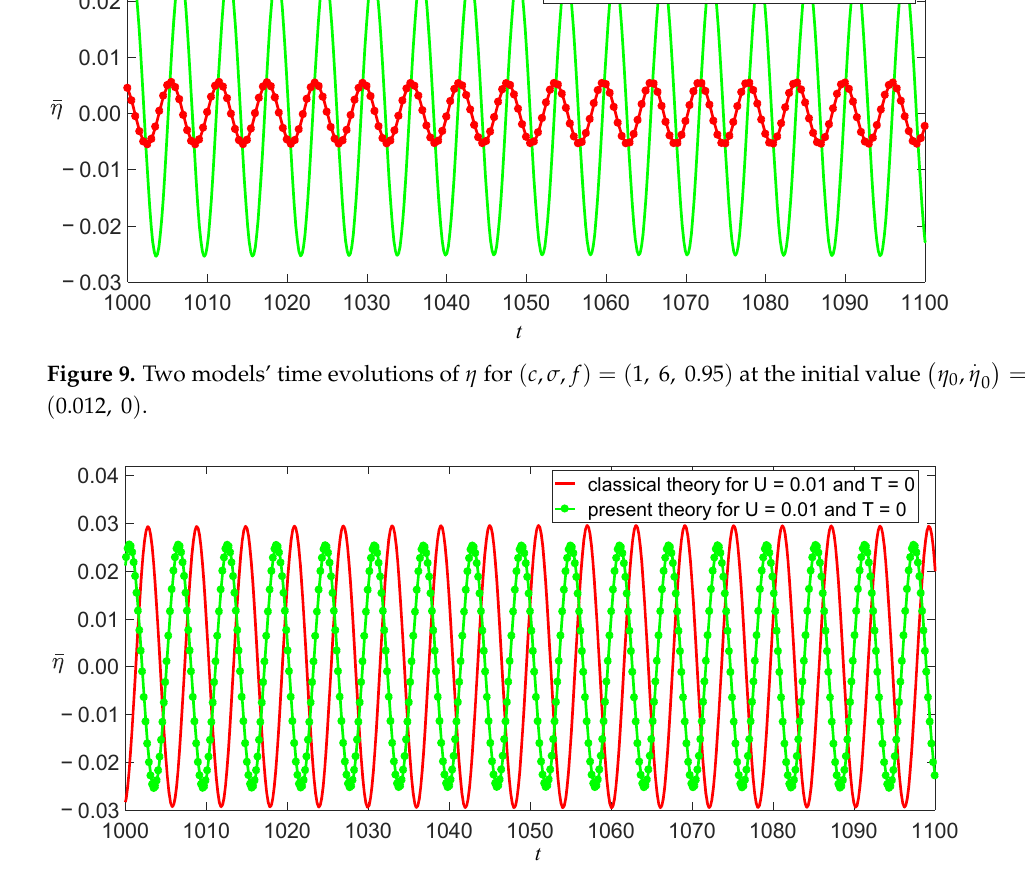
. (cid:1) = (cid:0) η 0 , η 0